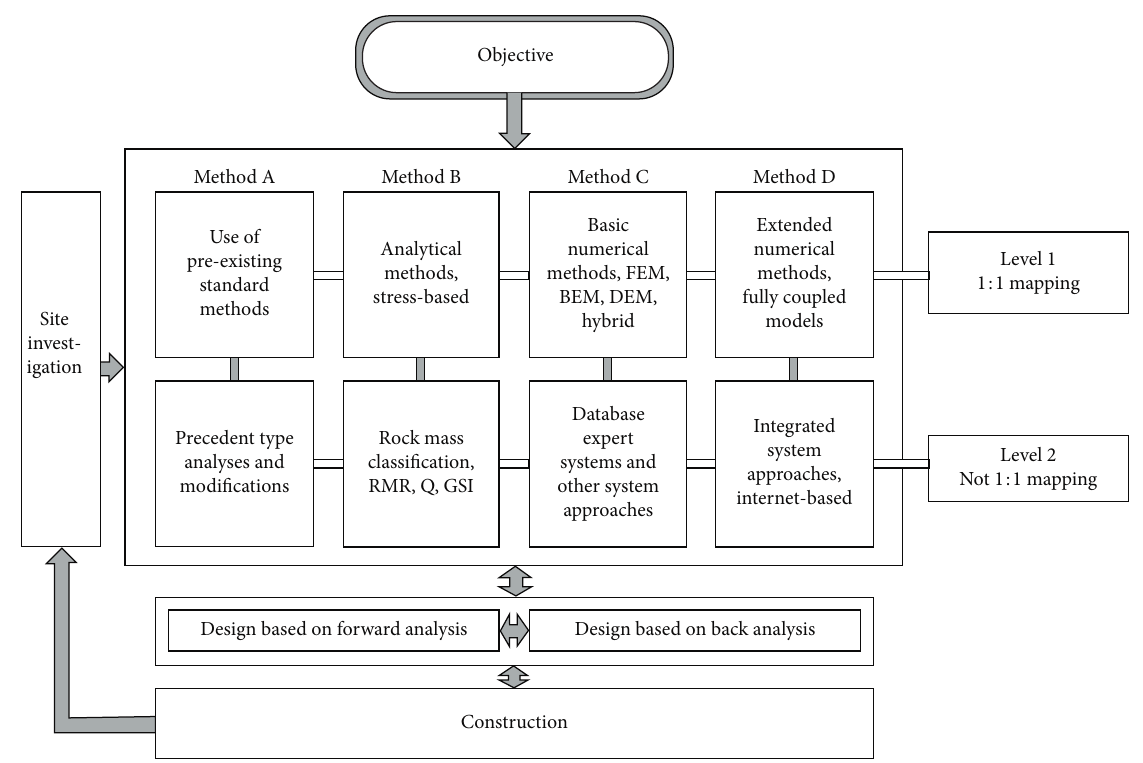
Figure 1: Summary of different methods for the solution of rock engineering problems